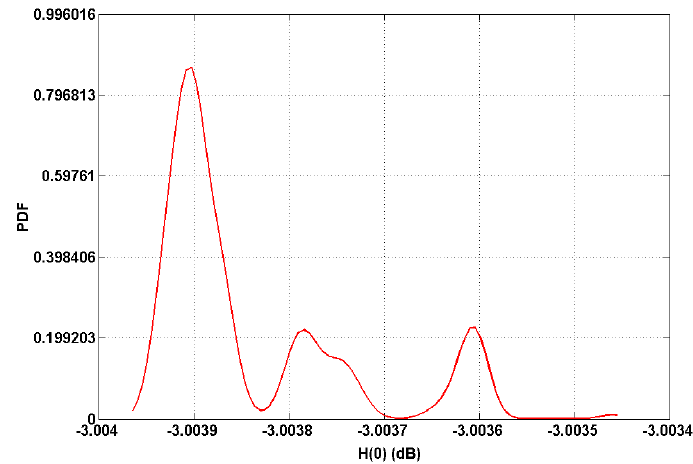
Figure 6. Probability density function (PDF) of optical channel